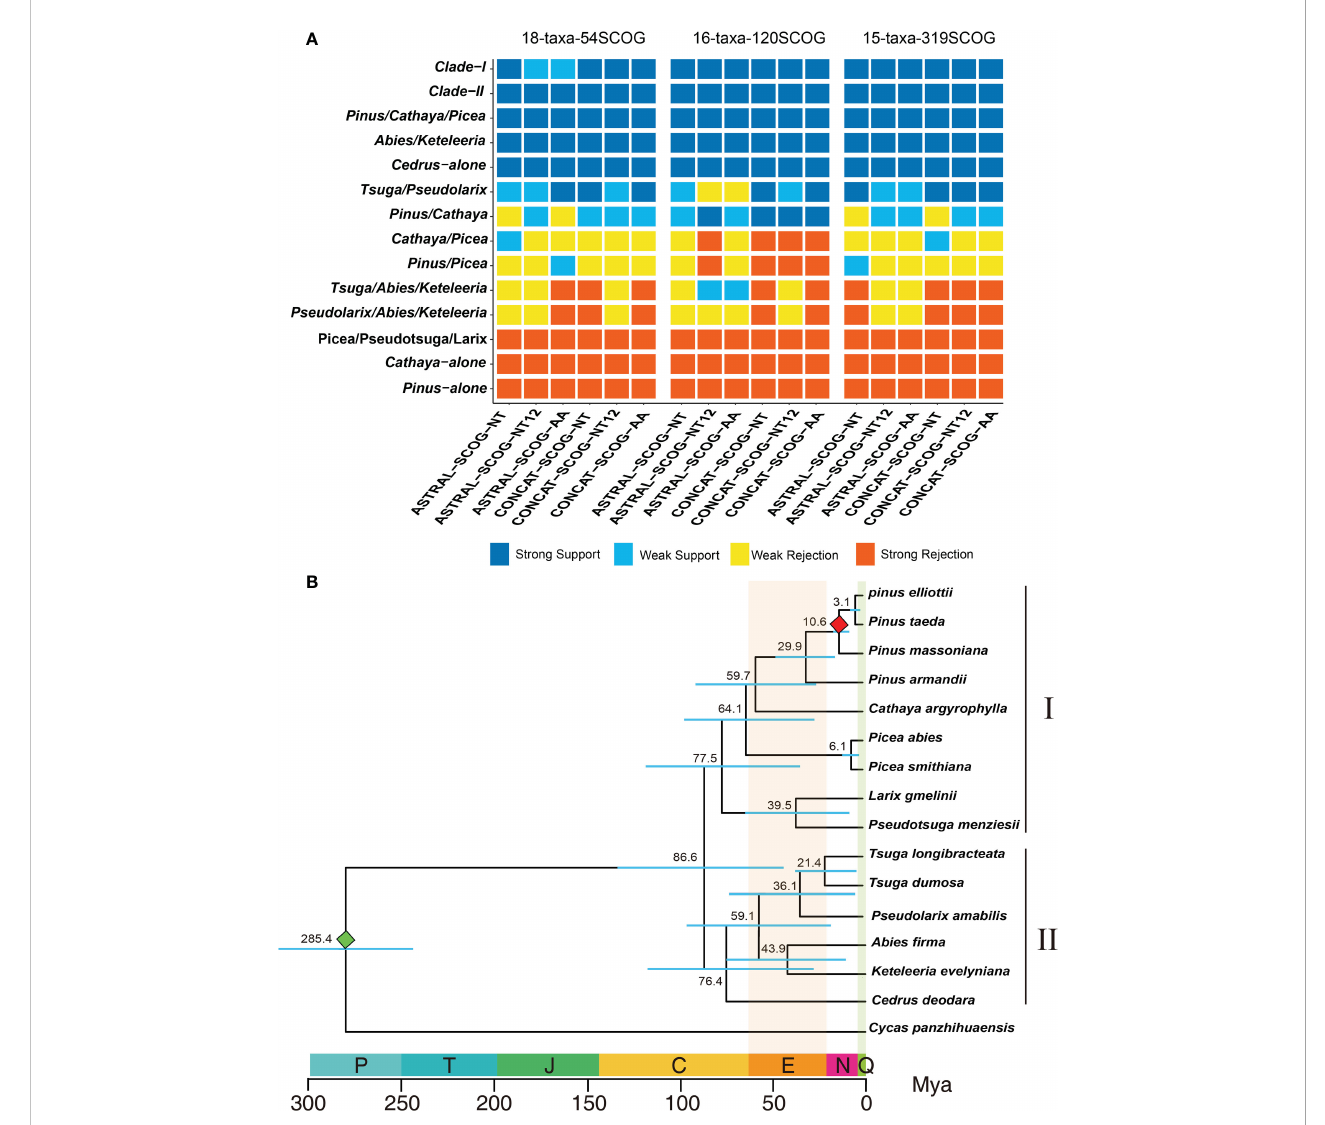
FIGURE 3 Determination of the fi nal species tree and divergence time calculation. (A) DiscoVista species tree analysis: rows correspond to the 14 hypothetical groups tested, and columns correspond to the results derived from the use of different datasets and methods. SCOG, single-copy orthologous gene; NT, nucleotide sequences; NT12, 1st+2nd codon positions; AA, amino acid sequences; ASTRAL, coalescent tree inference method using ASTRAL; CONCAT, maximum likelihood tree inferred with IQ-TREE based on concatenated datasets. Strong support, the clade is reconstructed with a support value >95%. Weak support, the clade is reconstructed with a support value <95%. Weak rejection, the clade is not recovered, but the alternative topology is not con fl icting if poorly supported branches (<85%) are collapsed. Strong rejection, the clade is not recovered, and the alternative topology con fl icts even when poorly supported branches (<85%) are collapsed. (B) Chronogram of pine plants on the basis of 120 single-copy orthologous genes ’ 1st+2nd codon sequences inferred using MCMCTree. The red and green diamonds indicate the divergence time of P. massoniana and C. panzhihuaensis , respectively. P, Permian; T, Triassic; J, Jurassic; C, Cretaceous; N, Neogene; Q, Quaternary; Mya, million years